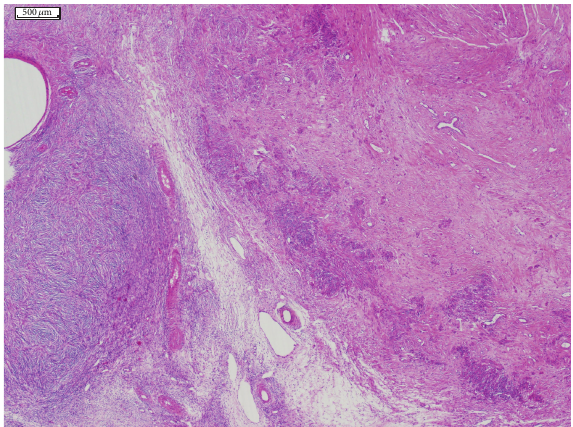
Figure 2: Ovarian leiomyoma with the ovarian capsule on the left, H-E × 2.